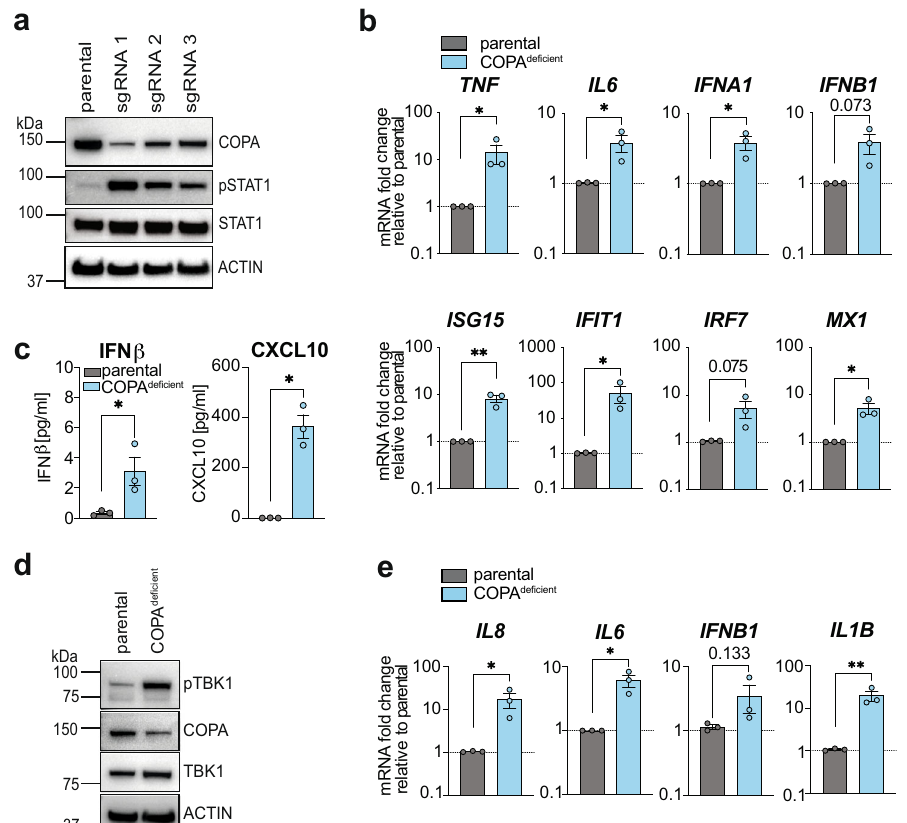
Fig. 1 Cell line models for COPA syndrome. a CRISPR/Cas9 gene editing technology was employed to generate COPA de fi cient THP-1 cell lines. Three different single guide (sg) RNAs targeting exon 5 (sgRNA 1), exon 1 (sgRNA 2) or exon 7 (sgRNA 3) of the COPA gene were used. Baseline protein levels of COPA and phosphorylated STAT1 (pSTAT1) were assessed by immunoblotting, using ACTIN as a loading control. Representative result of n = 3 independent experiments. b qRT-PCR analysis of transcription levels of proin fl ammatory cytokines, type I IFN and ISGs at baseline was performed for